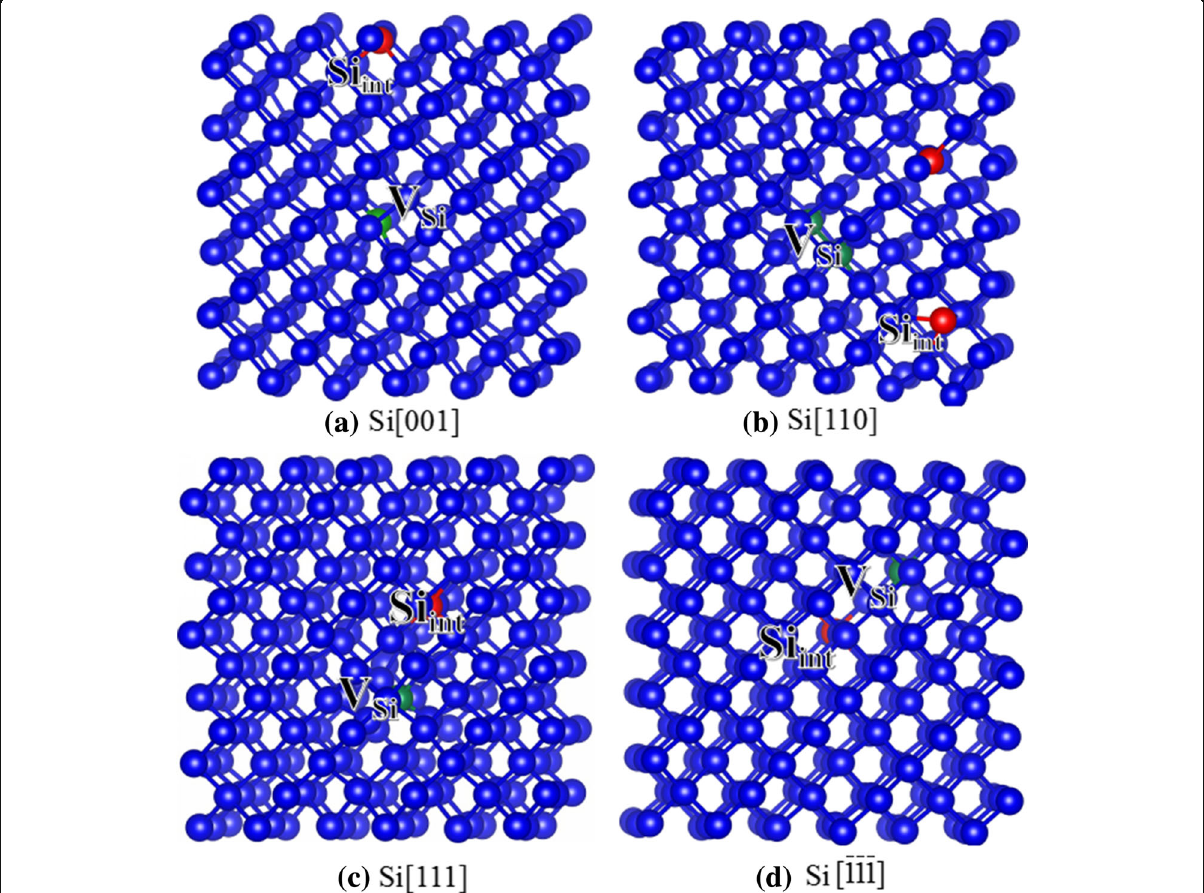
Fig. 2 a – d Schematic view of geometrical structures of damage Si after recoil events. The green and red spheres represent the vacancy and interstitial defects, respectively. V Si : silicon vacancy; Si int : silicon